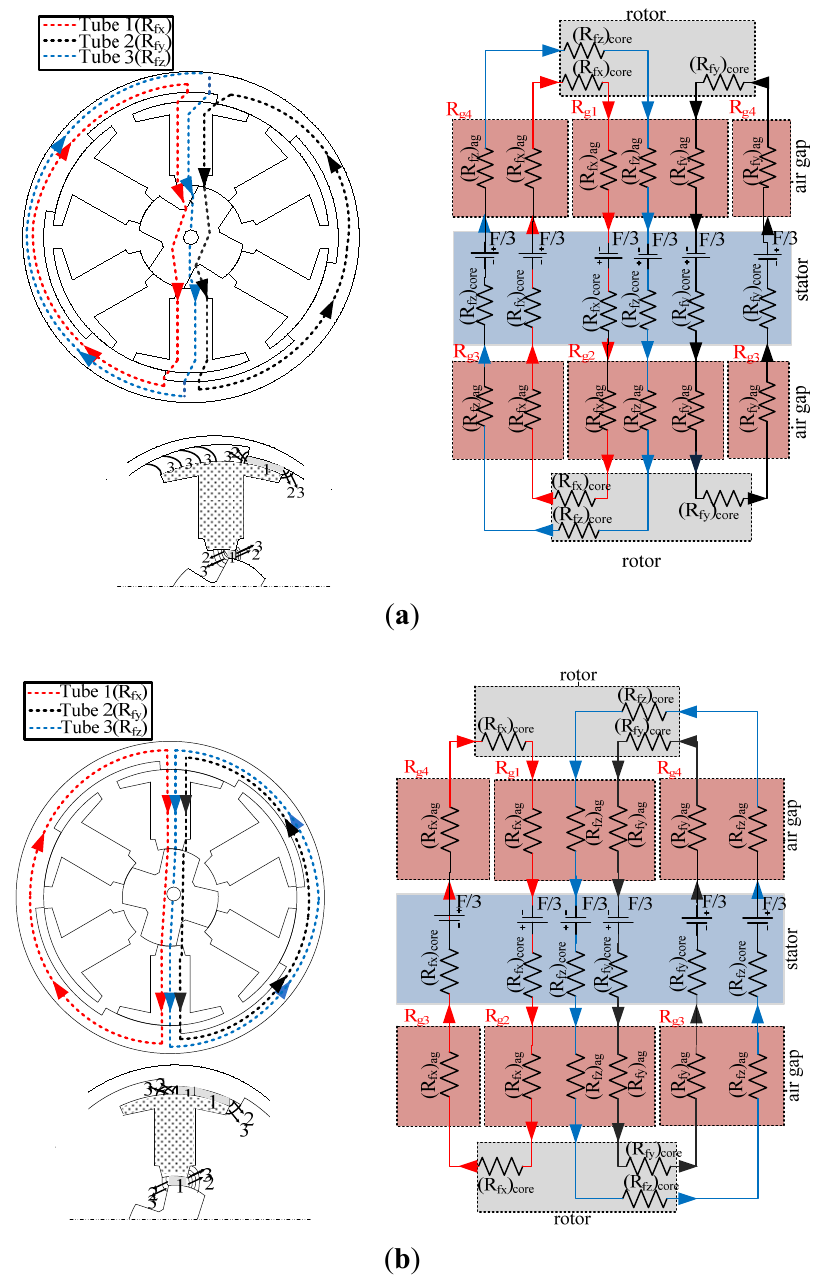
Figure 6. Analysis during partial-aligned positions: ( a ) 1/4th aligned flux analysis; ( b ) 3/4th aligned flux